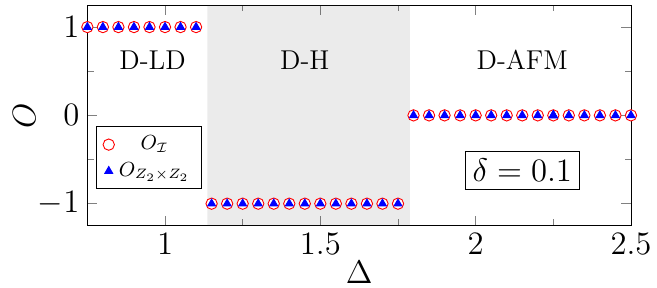
× Z and Z spin I 2 2